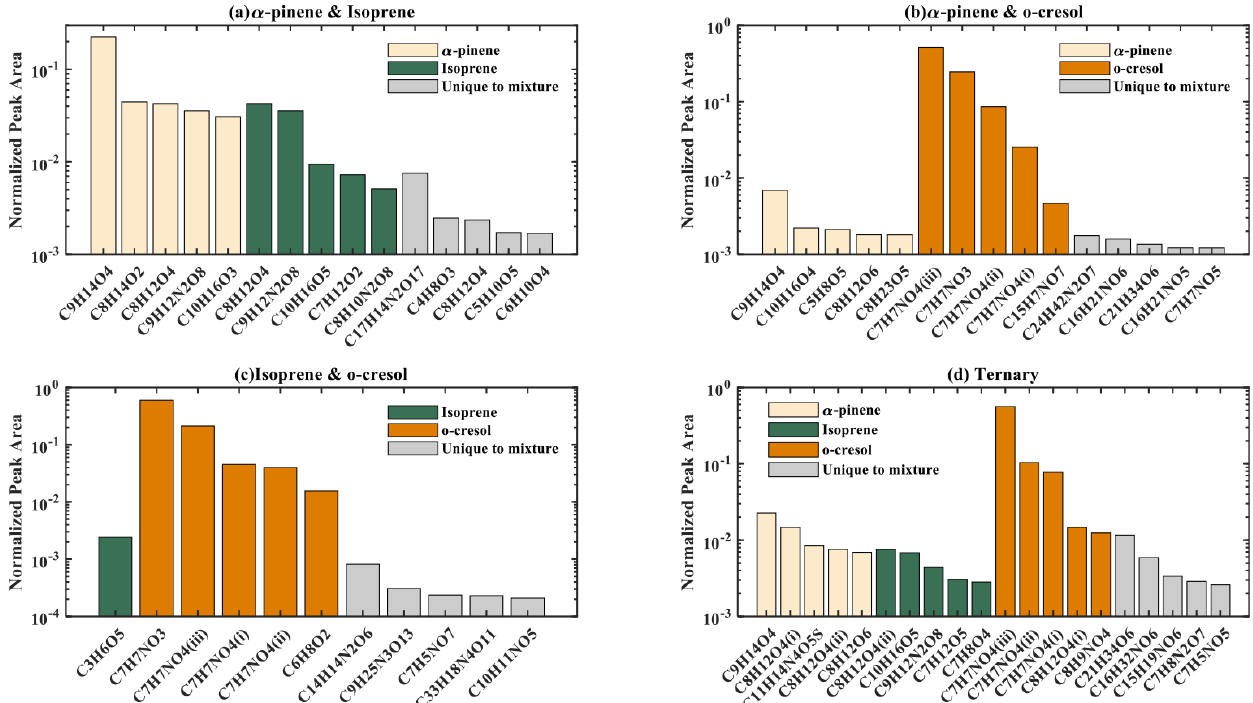
Figure 6. The dominant compounds in terms of their normalized peak area in the mixed VOC systems shown in the bars: (a) binary α - pinene–isoprene system, (b) binary α -pinene– o -cresol, (c) binary isoprene– o -cresol, (d) ternary system. The normalized peak areas of these selected compounds in a mixed precursor system are also presented if they existed in the corresponding single precursor system (yellow: single o -pinene, green: isoprene, orange: o -cresol) . The compounds are considered identical in the mixed system and single VOC systems if they have the same empirical formula and a retention time difference of < 0.1min in negative ionization